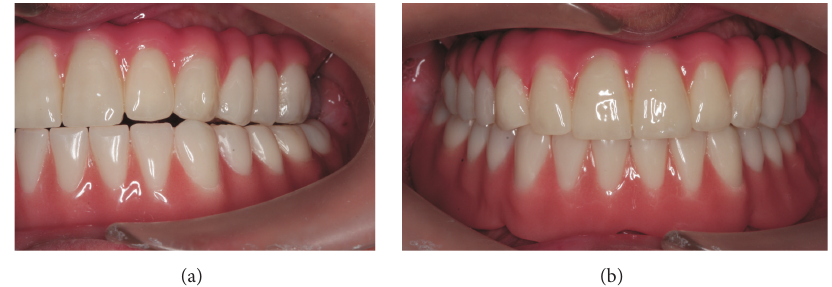
Figure 12: Occlusal adjustments at (a) lateral movement and (b) centric